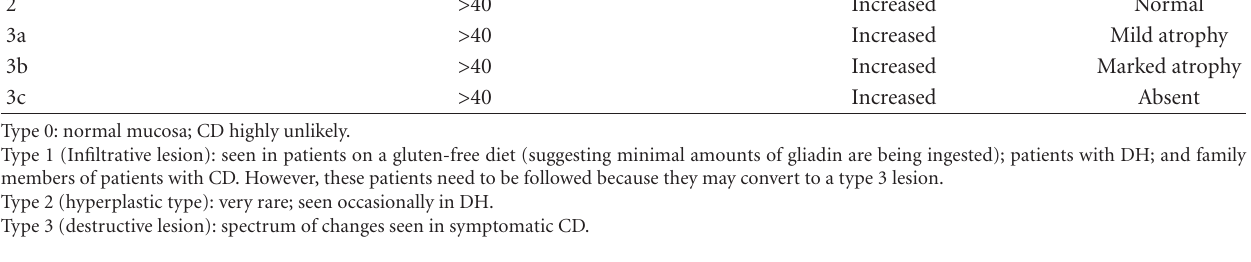
Table 2: Clinical characteristics and symptoms in patients with positive serologic tests for